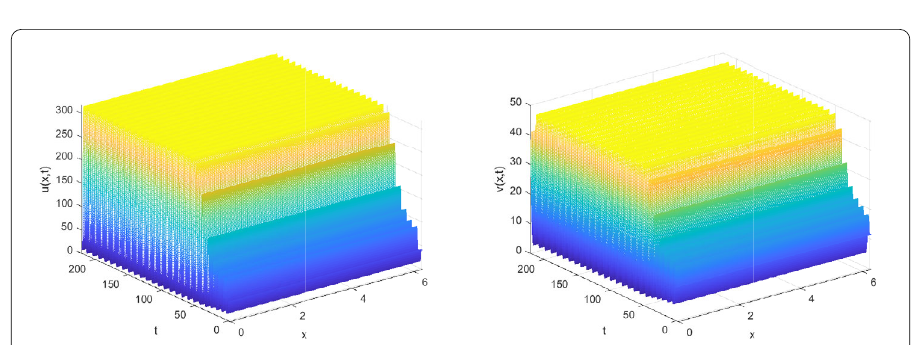
Figure 9 τ = 2.2 > τ 0 0 and the initial condition is (40.87,11.68). The system produces periodic solutions